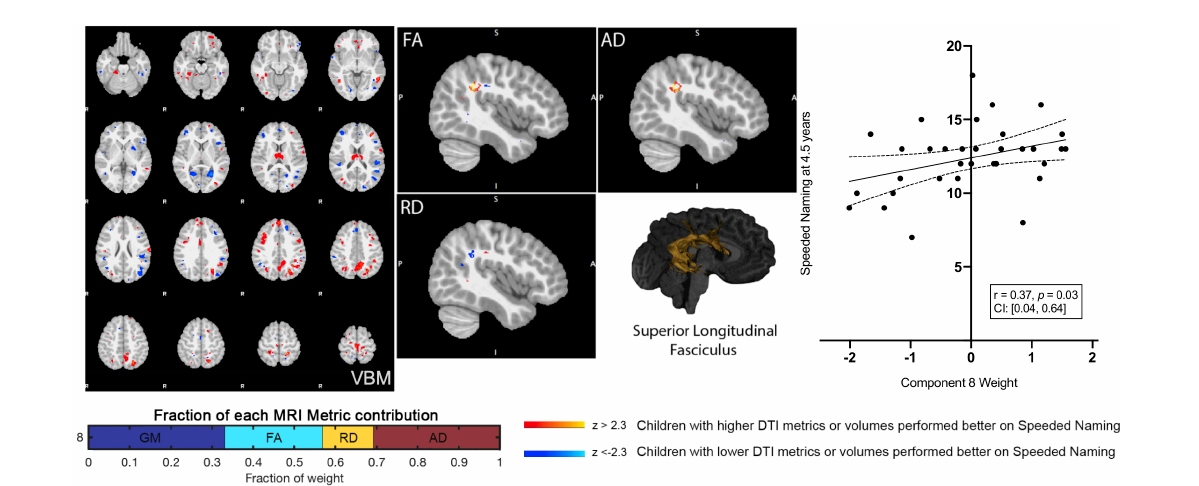
FIGURE2 Component 8 was approximately evenly weighed by the voxel-based morphometry (VBM) gray matter, fractional anisotropy (FA), radial diffusivity (RD), and axial diffusivity (AD) contributions. This component was positively correlated with Speeded Naming at 4.5 years. For regions in red (positive clusters), children with larger volumes/higher DTI metrics performed better on Speeded Naming, and for regions in blue (negative clusters), children with smaller volumes/DTI metrics performed better on Speeded Naming. For reference, the superior longitudinal fasciculus is also